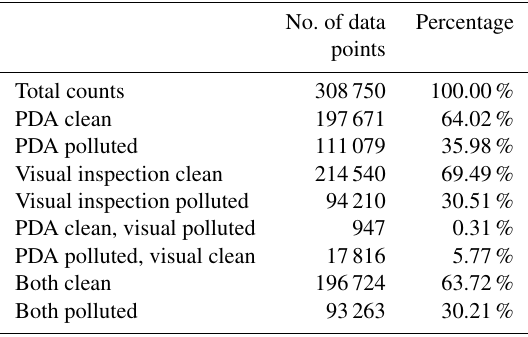
Table 3. Fraction of clean data points of the derivative filtering method and the visual filtering method compared to the total num- ber of data points (total counts) in numbers and in percent of the total counts. This table is based on the CPCf dataset at 1min time